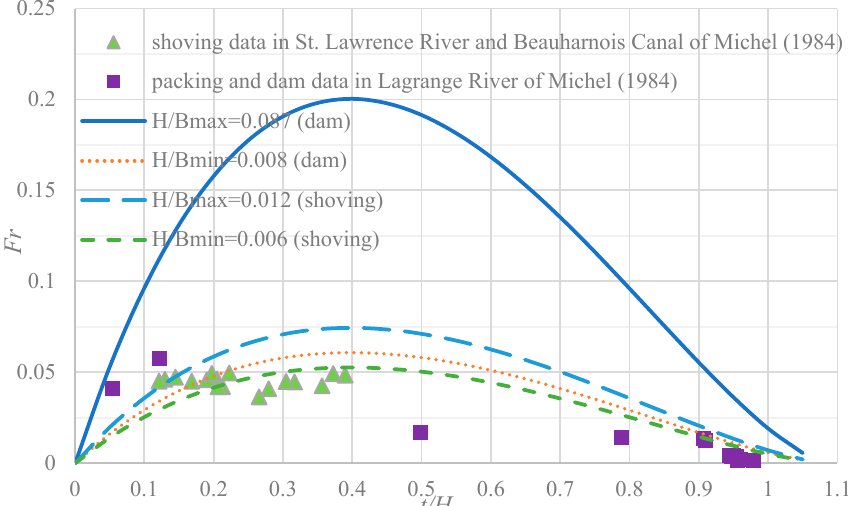
Figure 12. Variations of flow Froude number in front of the leading edge of ice jams with the relative thickness of an ice jam t / H —calculated results (curves) compared to those of field observations of the St. Lawrence River, Beauharnois Canal and La Grande River.